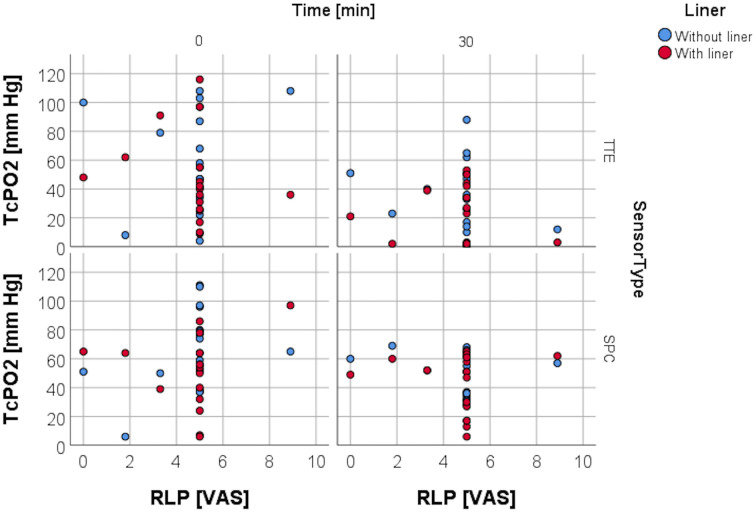
TcPO2 levels and RLP.Scattergram depicting distribution of TcPO2 levels with and without liner wear depending on the amount of residual limb pain.